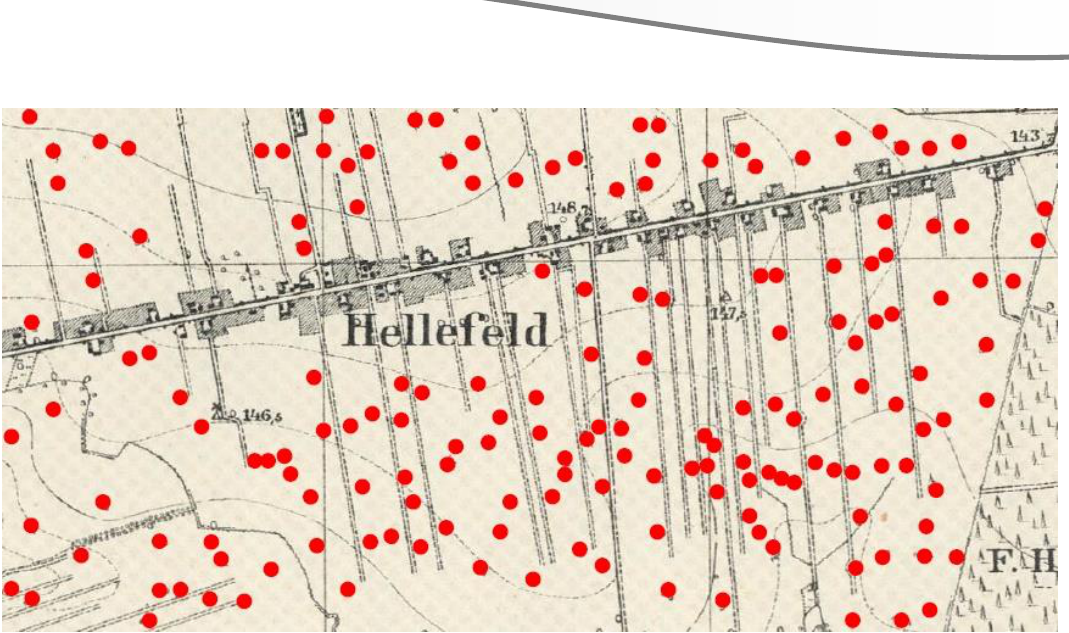
Figure 3: Distribution of PMH in small-sized and long-strip fields – an example from the surroundings of Jasne Pole (Hellenfeld) village (PMH are marked in red)